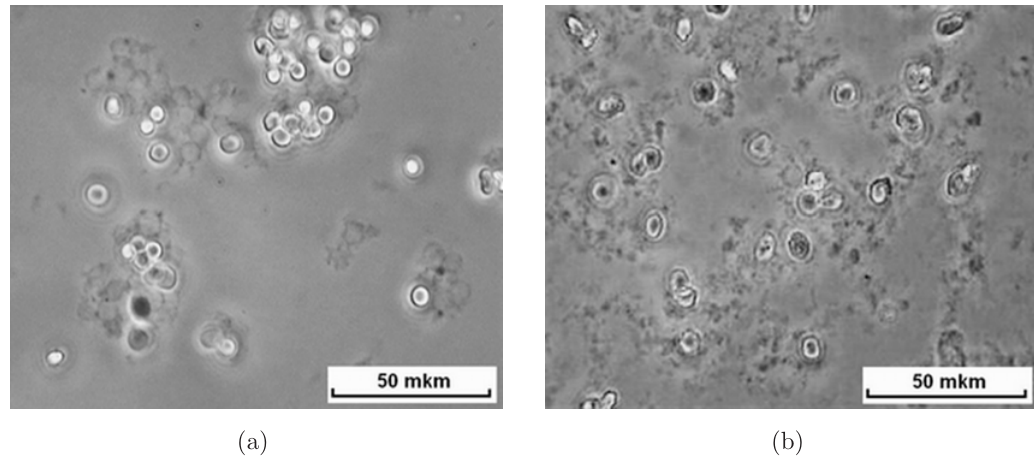
Fig. 4 Microphotographs of RBCs in the buffer suspension with (a) 0.1 wt.% and (b) 1.0 wt% modified silica